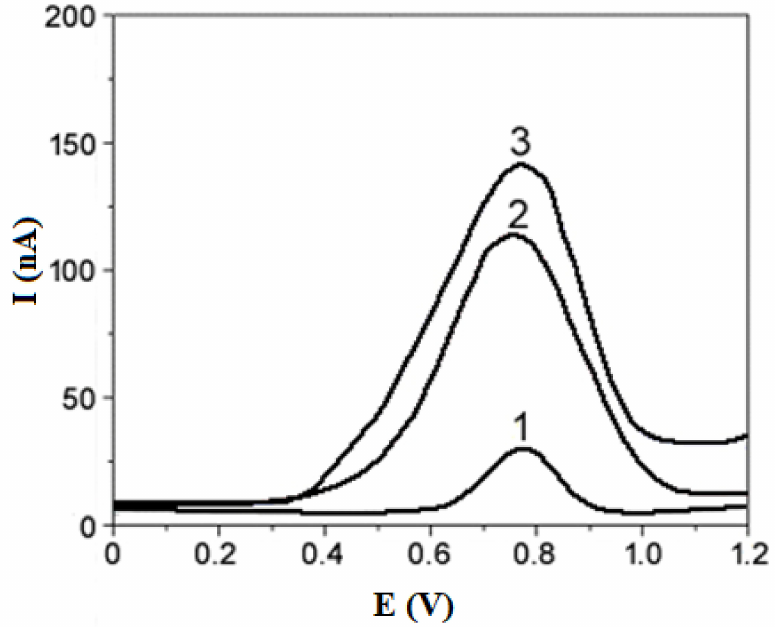
Figure 7. DPV curves registered for 0.5 mmol/dm 3 4-CP solutions in 0.1 mol/dm 3 Na 2 SO 4 using carbon paste electrodes containing 10 wt.%. of tested materials-modifiers: 1—bare CPE, 2—C-SB, 3—C-AO.